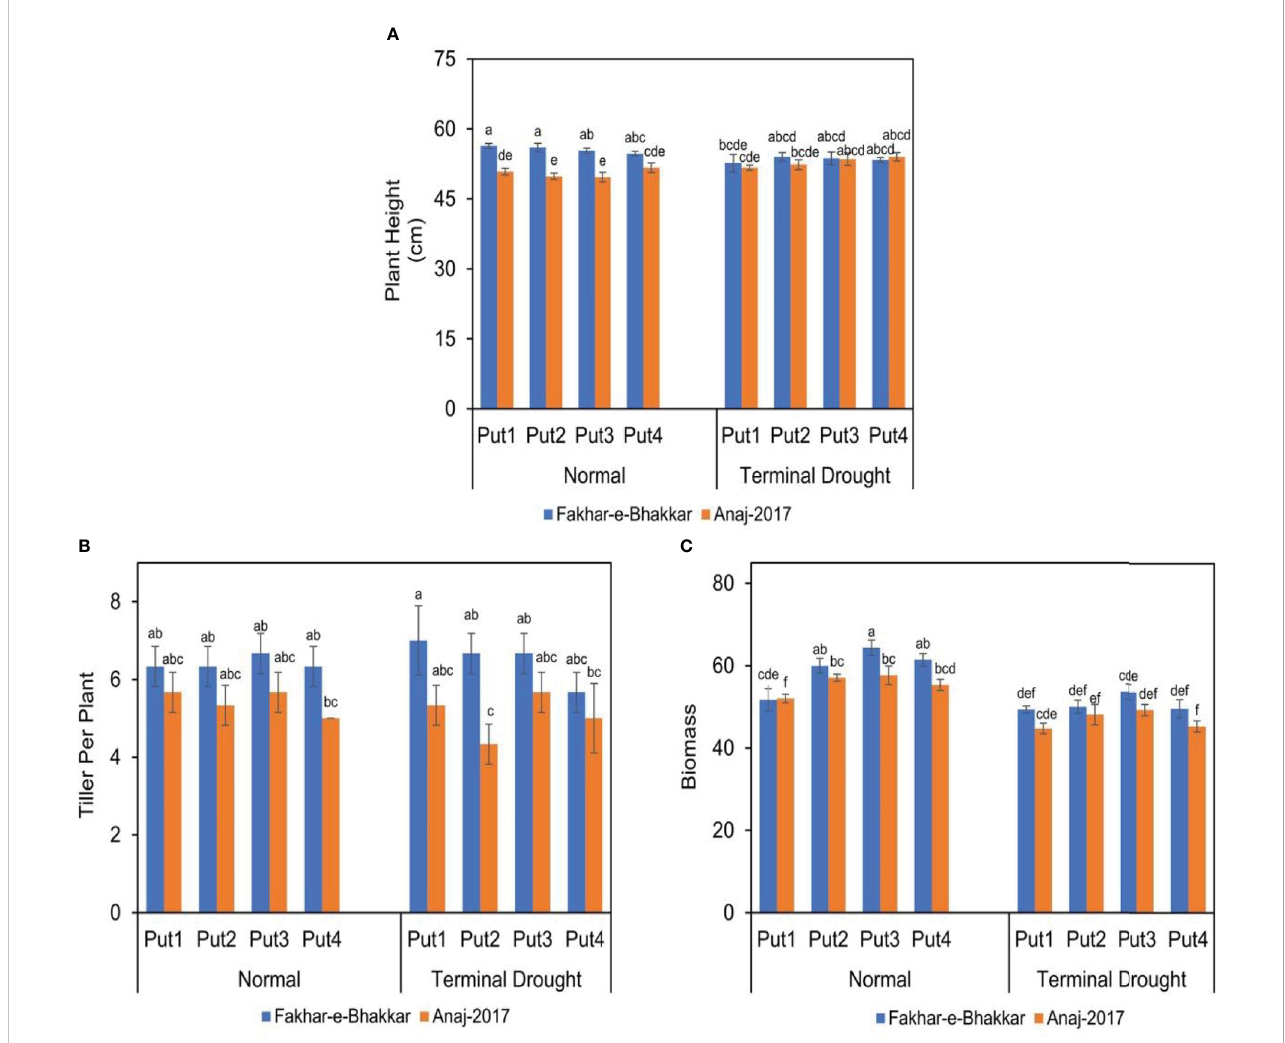
FIGURE 2 The effect of putrescine on the plant height (A) , tiller per plant (B) , and biomass (g plant-1) (C) of two wheat cultivars under normal and terminal drought conditions. Abbreviation: PPM, parts per million, Put1, putrescine 0 PPM (untreated control); Put2, putrescine 0.5 PPM; Put3, putrescine 1.0 PPM; Put4, putrescine 1.5 PPM. The different letters above the bar columns indicate signi fi cant differences in mean ± SE at p< 0.05. At least three independent biological replications were considered for each